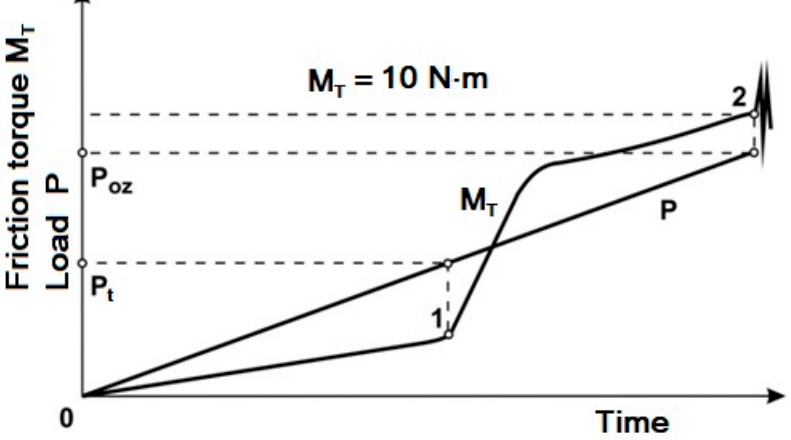
Figure 9. Typical course of changes in friction torque (M T ) as a function of load (P). Four-ball machine-Tester T-02.